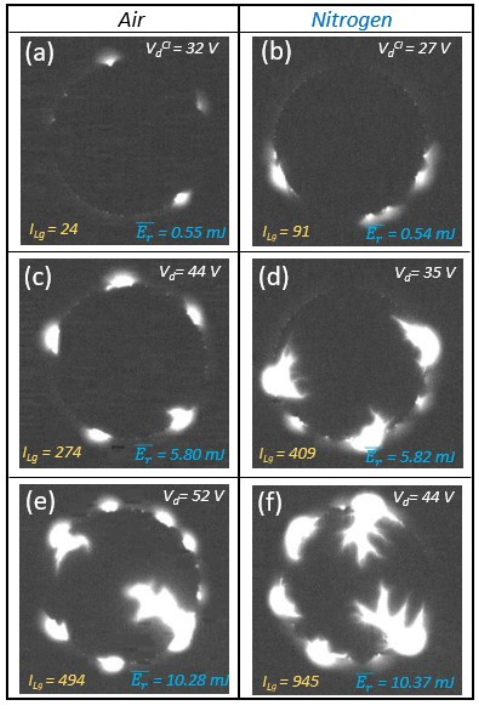
Figure 10. Natural luminosity images of streamers evolution in air ( a , c , e ) and nitrogen ( b , d , f ) at different driving